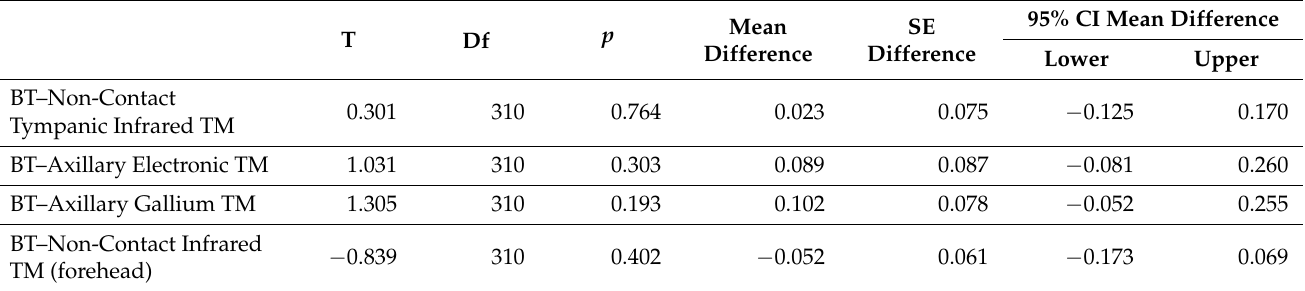
Table 6. Independent samples t -test: bed location and body temperature.